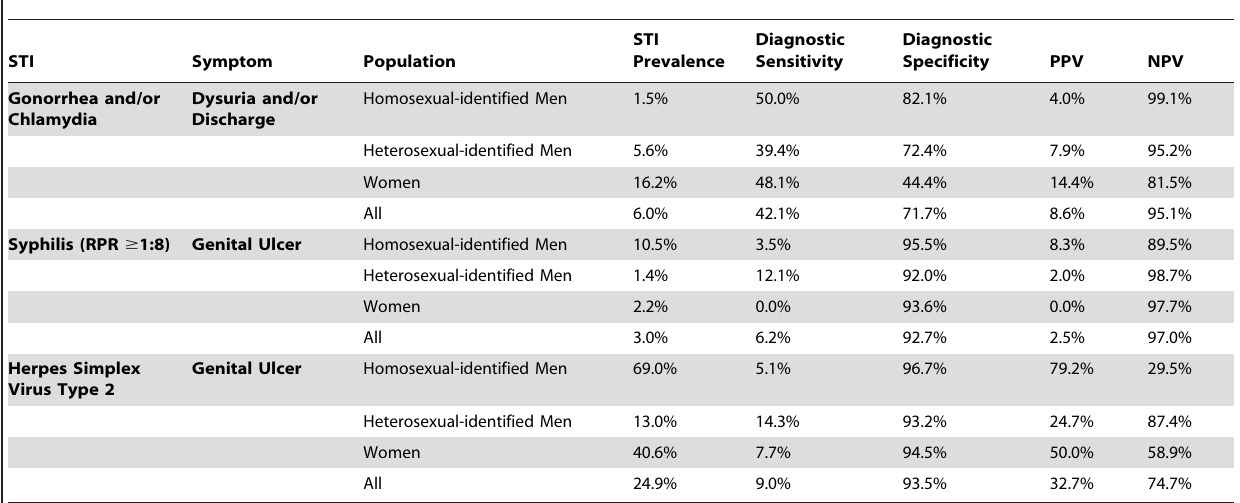
Table 4. Diagnostic Performance of STI Symptoms; Lima, Trujillo, Chiclayo, Peru 2003–05.